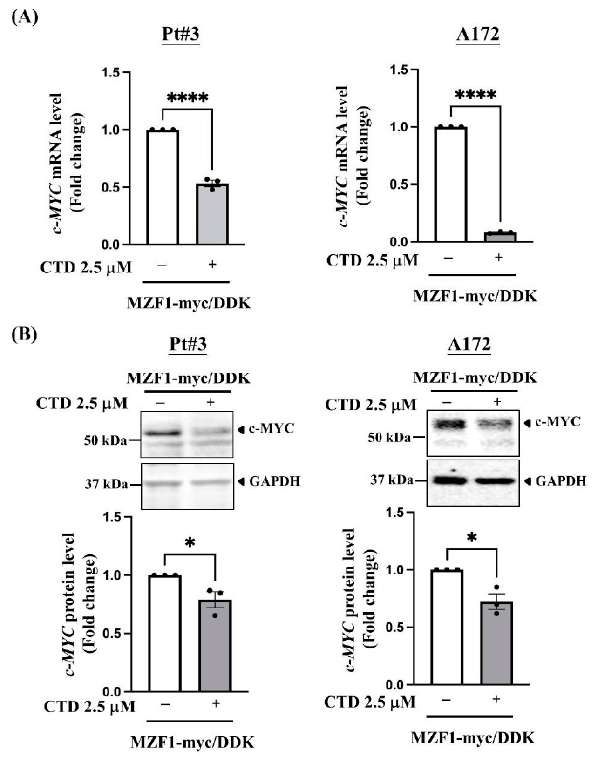
Figure 5. MZF1-induced expression of c-MYC was suppressed by cantharidin (CTD) in glioblastoma cells. ( A ) CTD treatment decreased the mRNA levels of c-MYC in MZF1-overexpressing glioma cells.